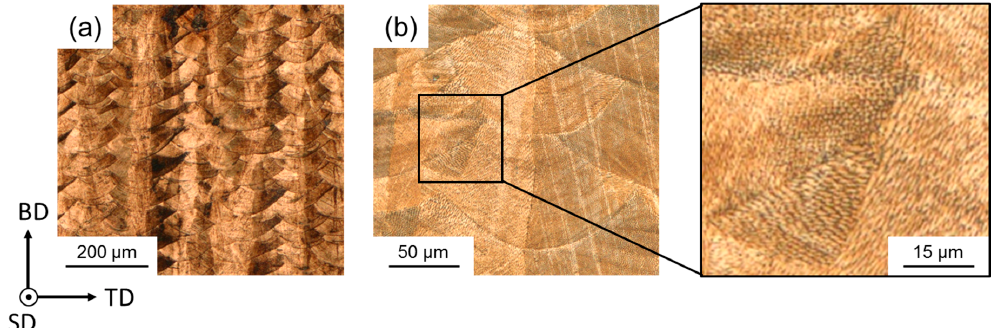
Figure 4. Optical micrographs of the investigated steel after SLM. ( a , b ) reveal the morphology of laser-melted tracks in the BD-TD plane. In addition, a fine cellular dendrite structure may be observed in the inset in ( b ).